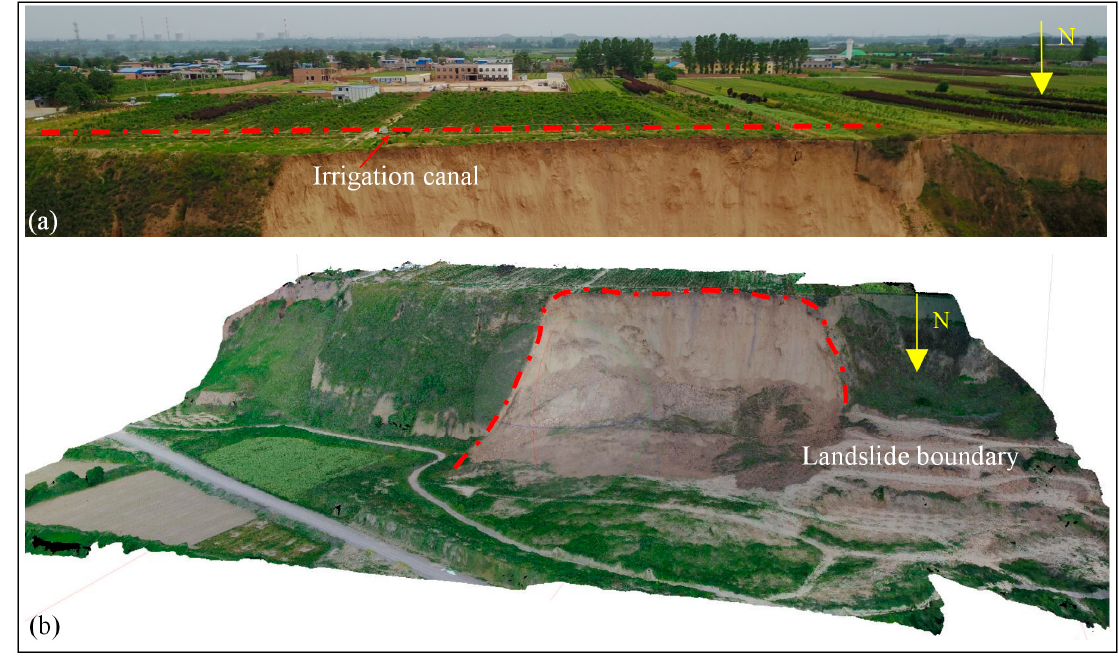
Figure 2. The sampling site. ( a ) Irrigation canal, ( b ) landslide boundary.